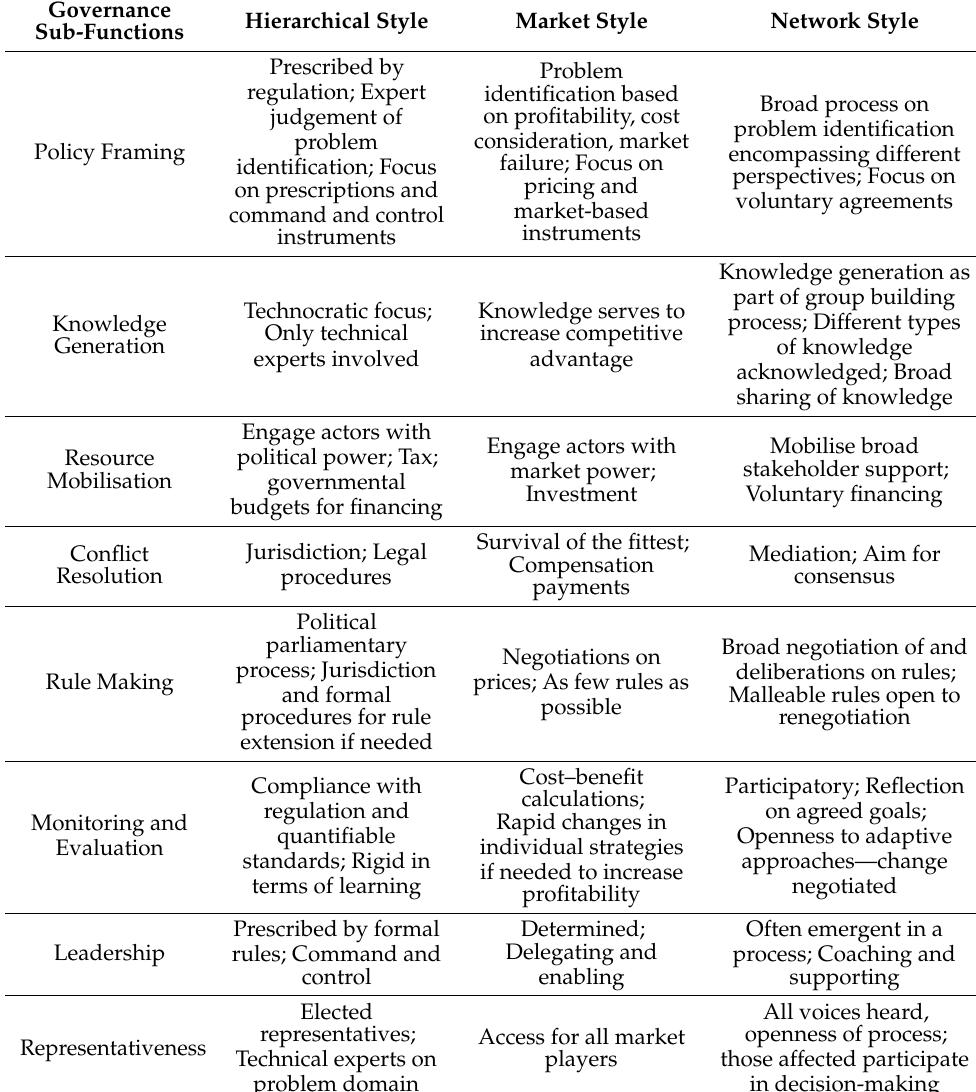
Table 2. Governance styles and their sub-functions—adapted from the governance sub-functions and governance properties in the three governance styles table in Pahl-Wostl (2015)